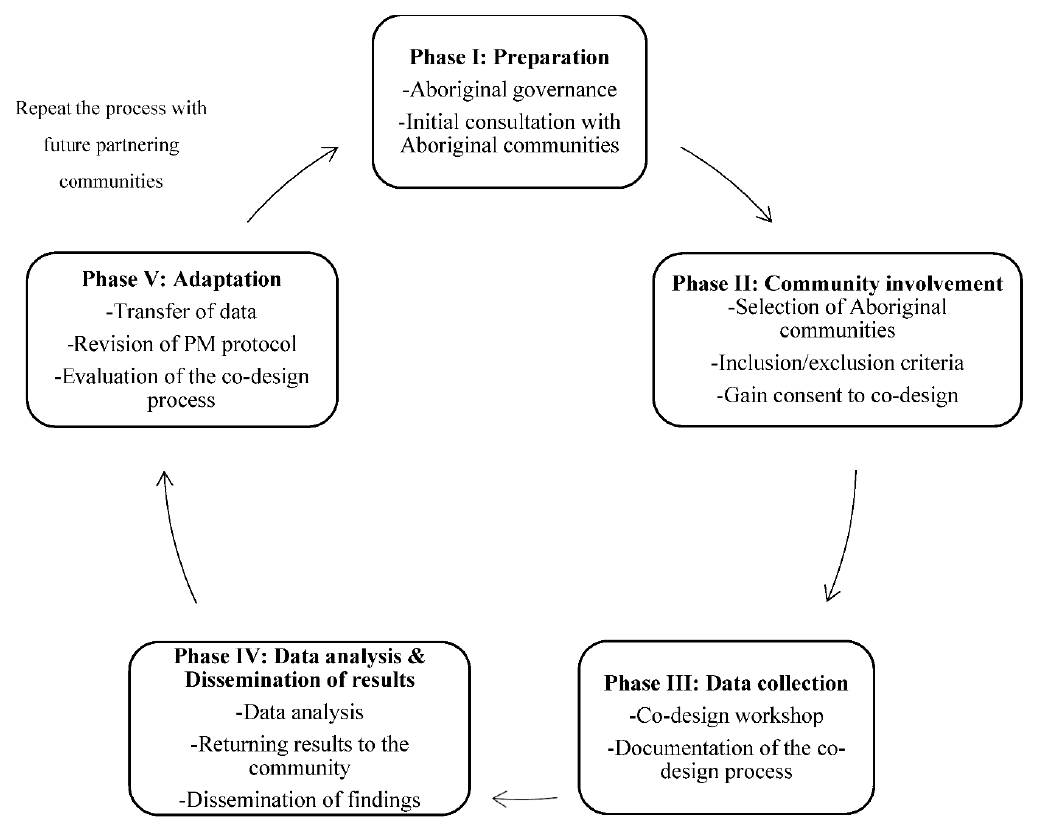
Figure 1. Five Phases of the Co-design Protocol.